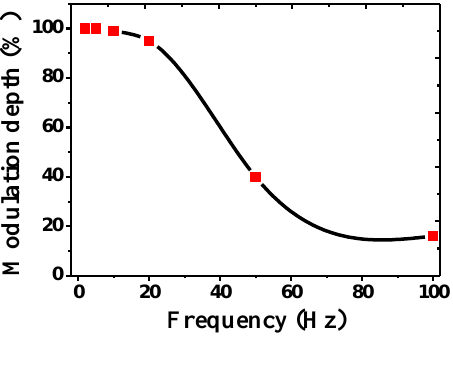
Figure 10. The modulation depth of the micro-heater ranging from frequency of 0~100